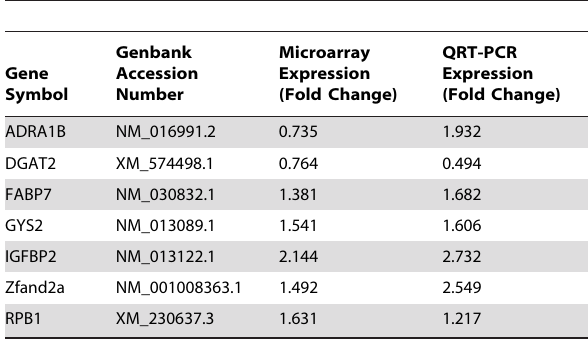
Table 3. Fold Change Values Comparing Microarray and QRT-